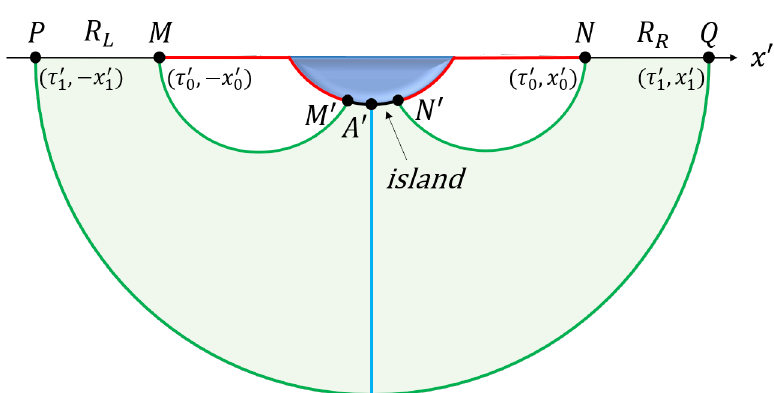
Figure 20. The disconnected phase viewed along z -axis. In this phase, the reflected entropy between R L and R R should include the contribution from the island, the interval on the brane bounded by M 0 and N 0 . From the bulk perspective, the reflected entropy is the area of the wedge cross section (blue line) plus the effective reflected entropy between | M 0 A 0 | and | N 0 A 0 | .